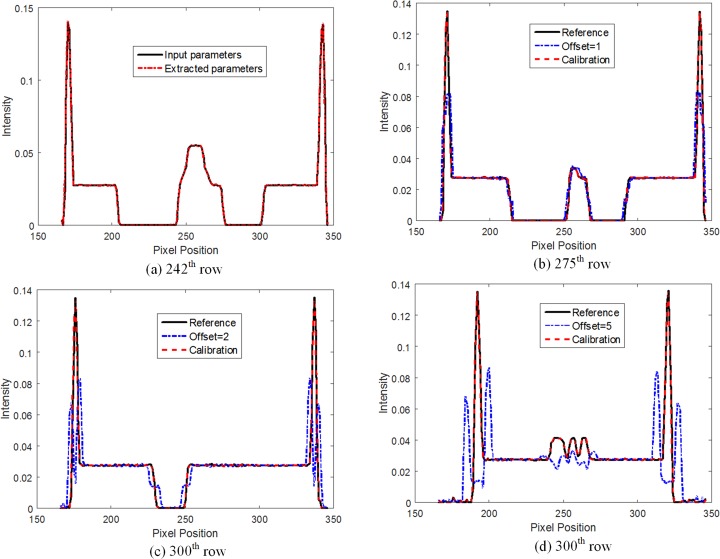
Profiles of different results shown in Fig 7.(a) Profile of the reconstructed images with input or extracted geometrical parameters without offset in the 242th row. (b) Profile of the reconstructed images with or without geometrical calibration with 1-pixel offset in the 275th row. (c) Profile of the reconstructed images with or without geometrical calibration with 2-pixel offset in the 300th row. (d) Profile of the reconstructed images with or without geometrical calibration with 5-pixel offset in the 335th row.